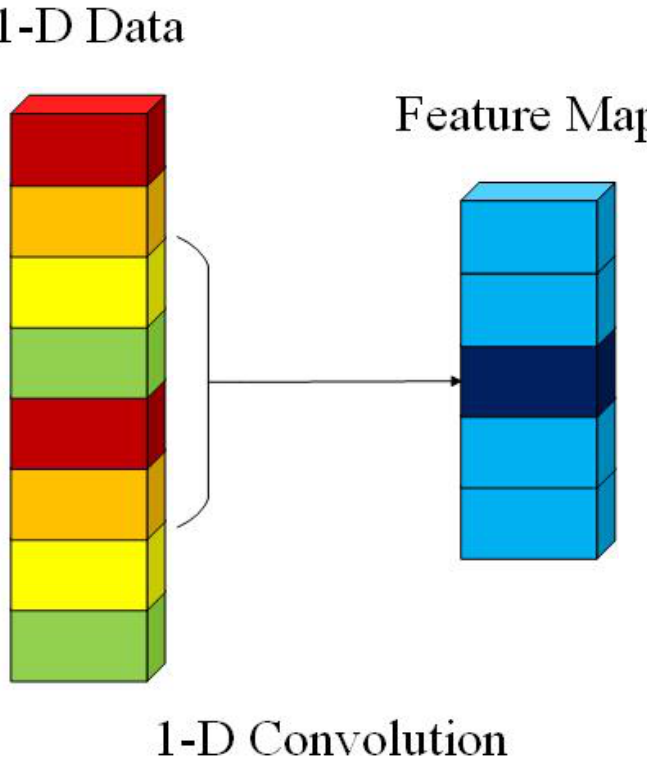
Figure 2. The computational process of 1-D